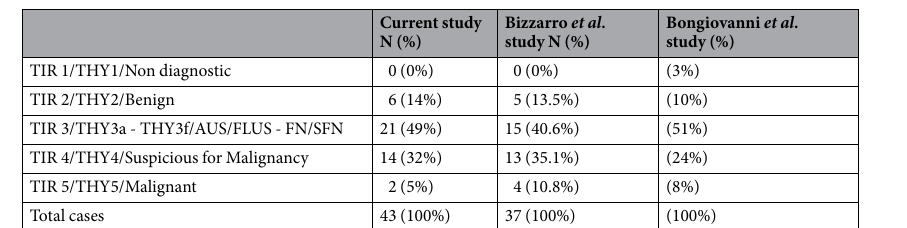
Bizzarro et al . study N (%)